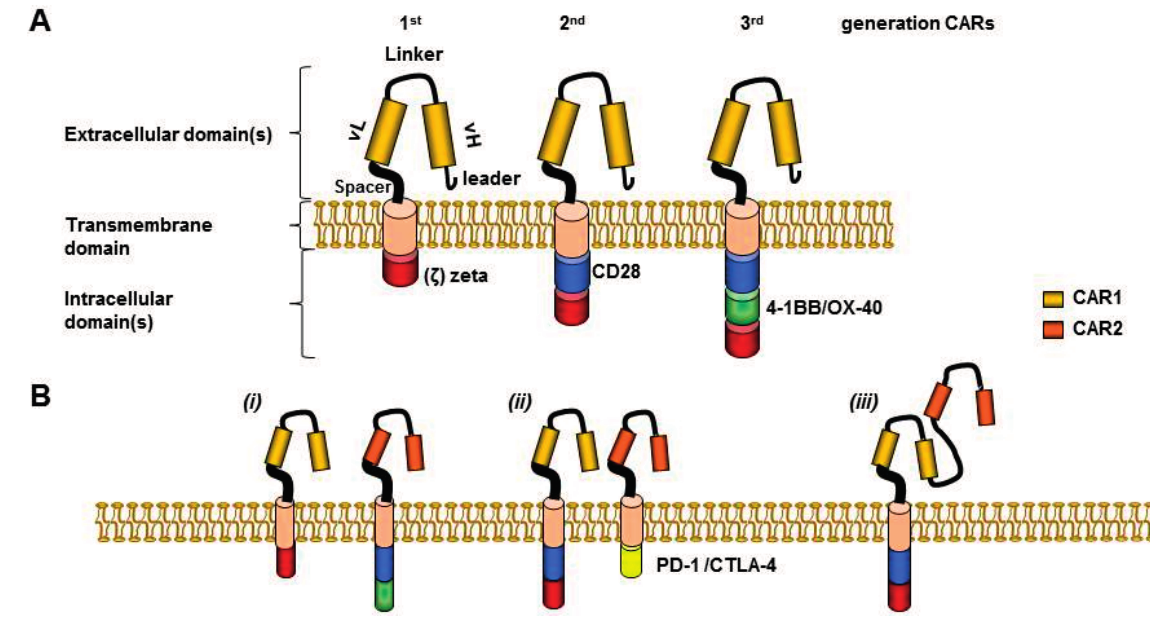
Figure 1. CAR constructs and dual targeting pre-clinical approaches to reduce toxicity. (A) CAR extracellular domain includes leader sequence, single chain variable fragment (scFv) (H (heavy) and L (light) chain), connected by a linker, (e.g., SG..GS). A spacer, (e.g., hinge region of human immunoglobulin D molecule) grants flexibility and joins to the transmembrane domain (TM). TM includes for example the constant region of the human G immunoglobulin, whereas the intracellular domain includes CD3 zeta endo-domain (1st generation CARs), plus minus a CD28 domain (2nd generation), or plus minus an additional co-stimulatory domain (3rd generation CARs) [28]. (B) “Dual targeting” approaches to reduce toxicities: (i) Trans-signaling CAR divides killing domain and co-stimulatory domain in separate molecules targeting two distinct tumor antigens, limiting CAR activation capacity when only a single antigen is engaged [29–31]. (ii) Inhibitory CAR replaces the zeta chain with an inhibitory domain, overcoming the activatory signal from a coexpressed activatory CAR [6]. (iii) Tandem CAR is composed by two different antigen binding fragments allowing targeting of two different antigens by a single construct, with synergistic effect when both are engaged simultaneously [32]. CAR-1 and CAR-2 used as example, recognized antigen 1 and antigen 2,